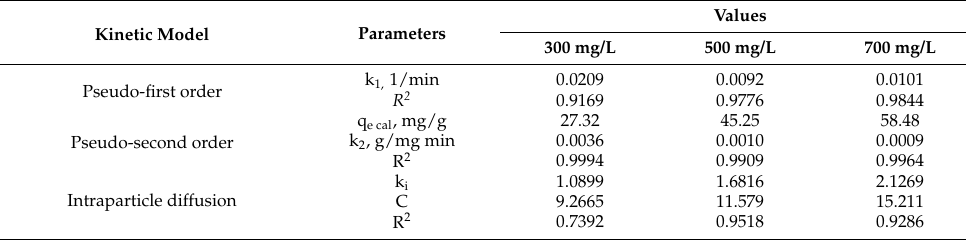
Figure 9. PFO model, PSO model, and intraparticle diffusion model for the adsorption of Cu(II) ions: ( a ) 300 mg/L; ( b ) 500 mg/L; ( c ) 700 mg/L. Table 5. Kinetic parameters of Cu(II) adsorption onto MFA.